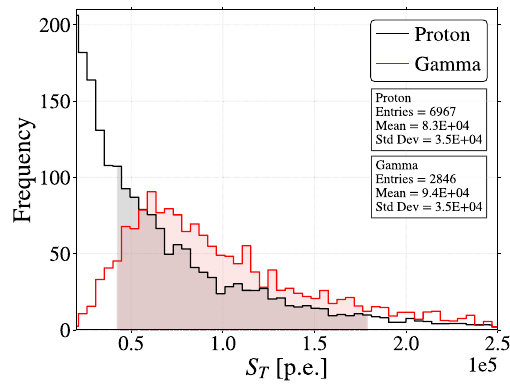
Fig. 3 Signal at the ground of gamma and proton induced EAS used in Sect. 5. The area below the selected events was filled in red for gammas and grey for protons. The statistical data showed in this figure corresponds only to the selected events